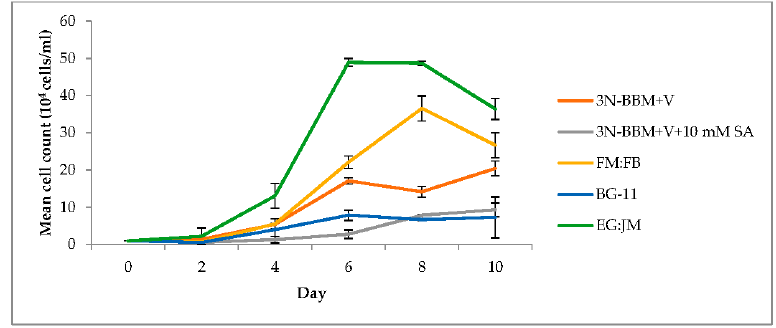
Figure 2. Effect of a range of media on the growth of H. pluvialis in the green stage. Mean cell count data ± S.D. ( n = 3). The green stage involved culturing at 20 °C, 40 µmol photons m − 2 ·s − 1 , 12:12 photoperiod, 150 rpm over a 10-day period.